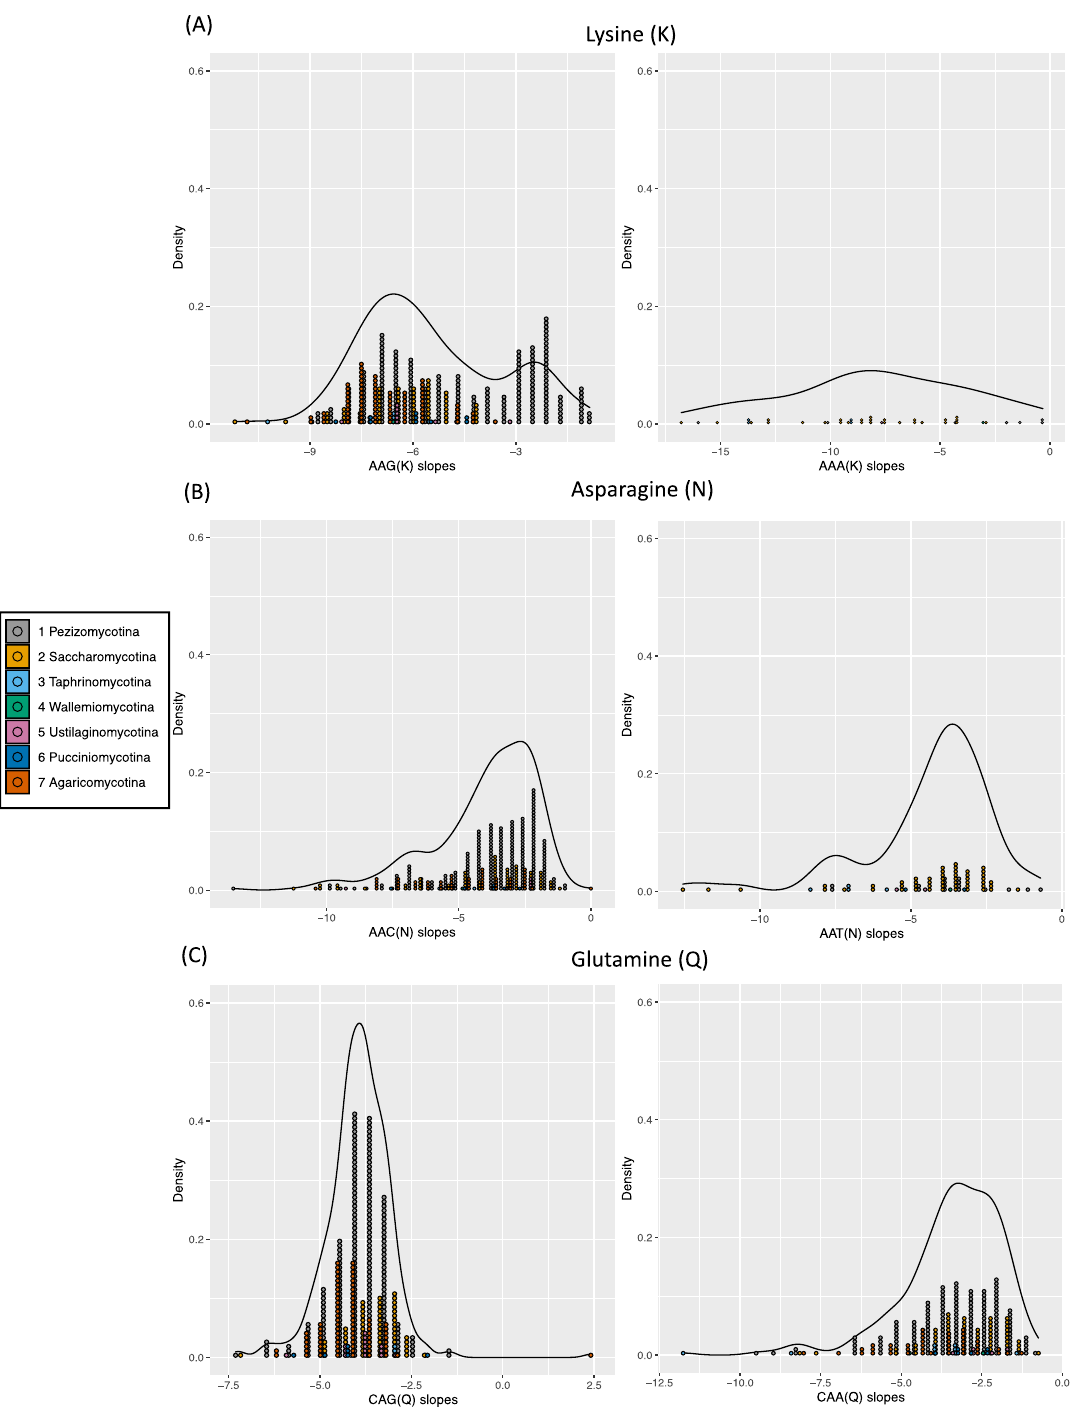
Figure 4. Histograms of length distribution slopes for two synonymous homocodons encoding poly-Lys, poly-Asn and poly-Gln from the top-20 lists of homocodon frequencies. Histograms of the log–log plot slopes for length distributions are plotted (one panel for each synonymous codon). They are binned in intervals of 0.5. For each pair of panels taken together, the total histogram area for each subphylum equals the number of occurrences in the top-20 lists for each homocodon in each subphylum. The lines indicate the overall distribution within each panel. More negative values indicate more, short homopeptides: ( a ) Comparison of Poly-AAG(K), left panel and Poly-AAA(K), right panel; ( b ) Comparison of Poly-AAC(N), left panel and poly- AAT(N), right panel; ( c ) Comparison of Poly-CAG(Q), left panel and poly-CAA(Q), right